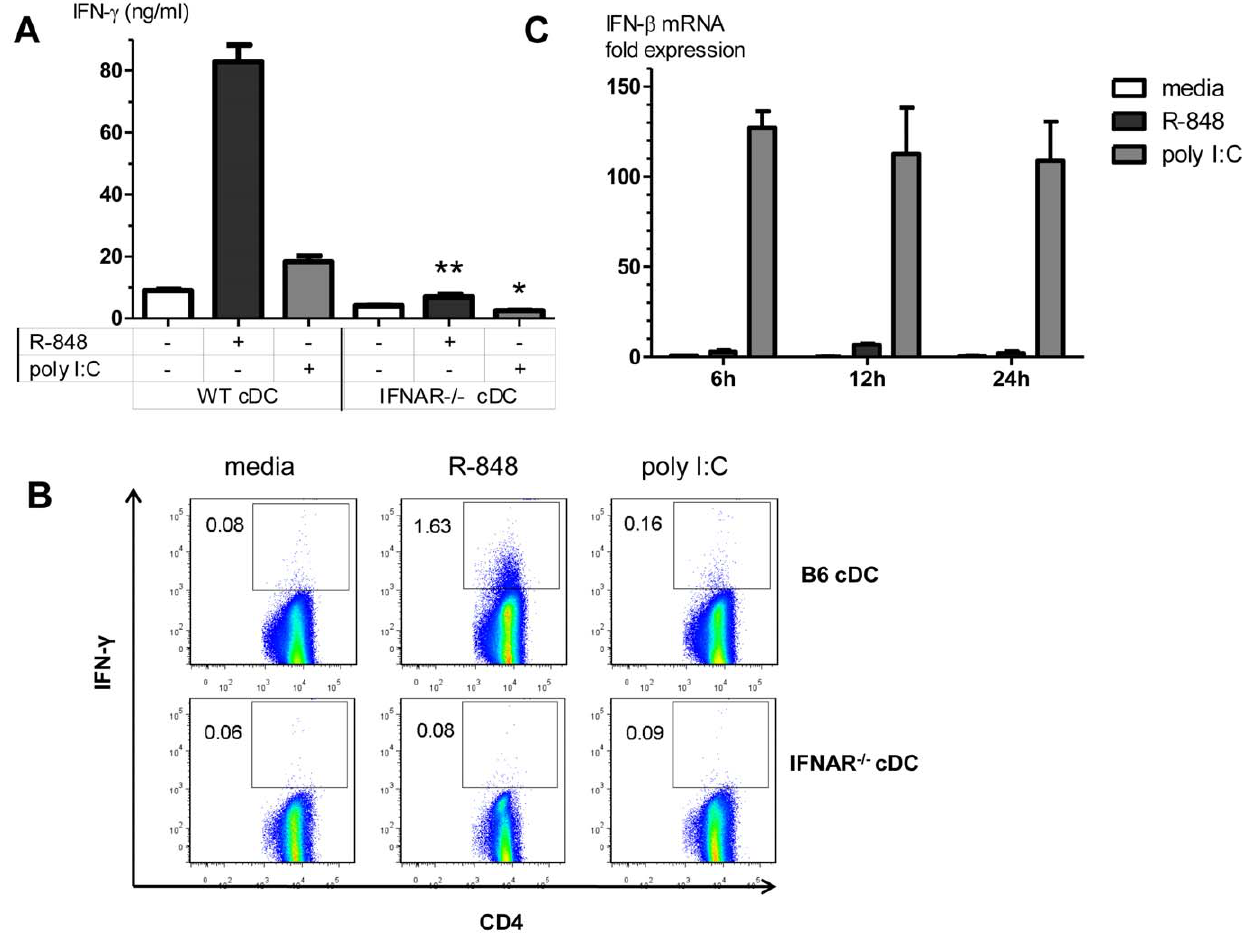
Figure 2. Type I IFN is essential for RNA-like IRMs to stimulate CD4 + Th1 responses in a cDC/CD4 + T-cell MLR. (A) IFN- c levels in cell culture supernatants in MHC congenic MLRs utilizing B6 or IFNAR 2 / 2 cDCs. Values are mean 6 SEM (n=3). ** p=0.0008 compared to R-848 stimulated B6 cDC MLR, * p=0.0037 compared to poly I:C stimulated B6 cDC MLR. (B) ICS staining for IFN- c producing conventional CD3 + CD4 + T-cells in MHC congenic MLRs utilizing B6 or IFNAR 2 / 2 cDCs (representative of three independent experiments shown). Values shown are the % of IFN- c + conventional CD3 + CD4 + T-cells. (C) cDCs were stimulated with R-848, poly I:C, or media (unstimulated control), and cellular RNA was collected at the indicated time points. IFN- b mRNA levels were measured by qRT-PCR, as described in the Methods section. Bars represent fold-change in IFN- b mRNA relative to unstimulated control at the 6 h time point (mean 6 SEM, n=3).